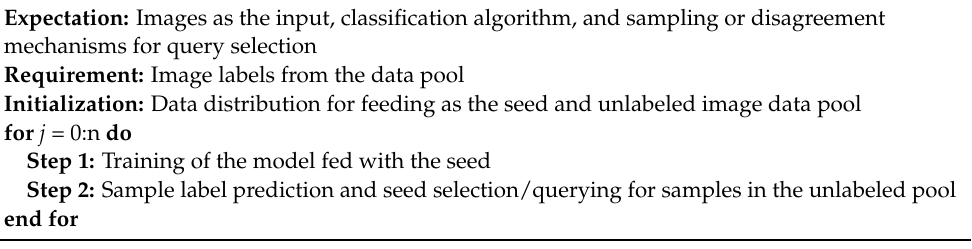
Algorithm 1. Retrieval of training data and labeling using AL for each participant node model. Expectation: Images as the input, classification algorithm, and sampling or disagreement mechanisms for query